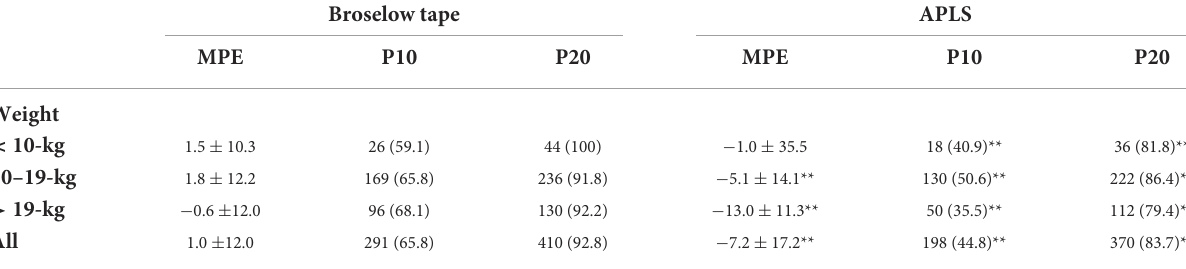
TABLE 3 Percentage error of the Broselow tape and formula estimated